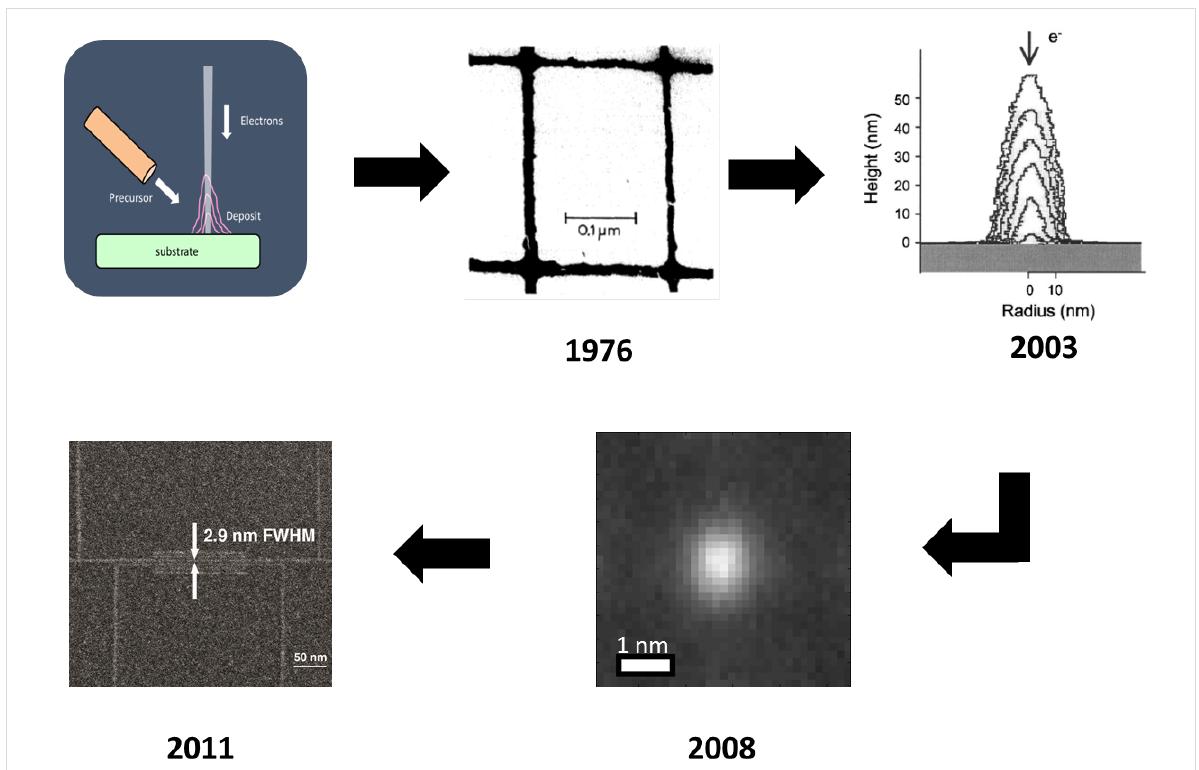
Figure 11: Schematic representation of the evolution of high-resolution electron beam induced deposition as a nanopatterning technique since its first demonstration in 1976. (Clockwise order) Schematic of EBID, 8 nm lines patterned by Broers et al. on a thin membrane [55]; simulation of dot grown on a thin membrane using a zero-diameter electron beam demonstrating the relevance of deposit-generated SEs in EBID [70]; experimental demon- stration of dots with average diameter of ca. 1 nm patterned on a thin membrane by EBID [64]; direct patterning of 3 nm dense lines on bulk Si/SiO 2 by EBID [65]. Reprinted with permission from [55] and [70], copyright 2003, 2013 AIP Publishing; reprinted with permission from [65], copyright 2011 American Vacuum